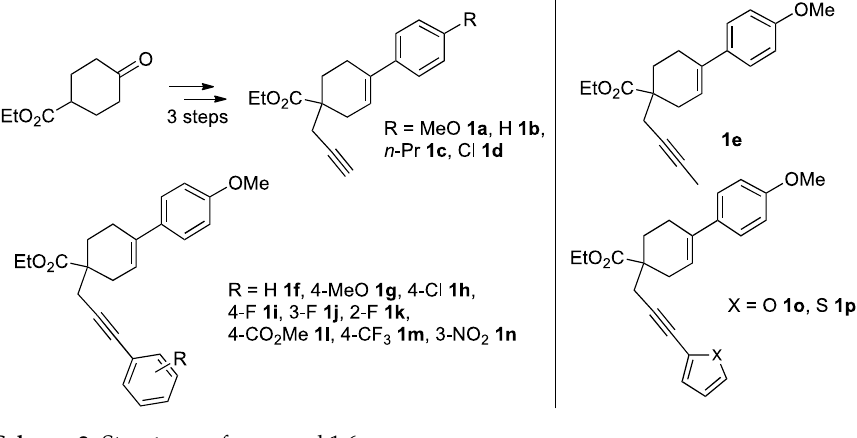
Table 1. Au and In-catalyzed cycloisomerization reaction of ethyl 4-oxocyclohexane carboxylate.